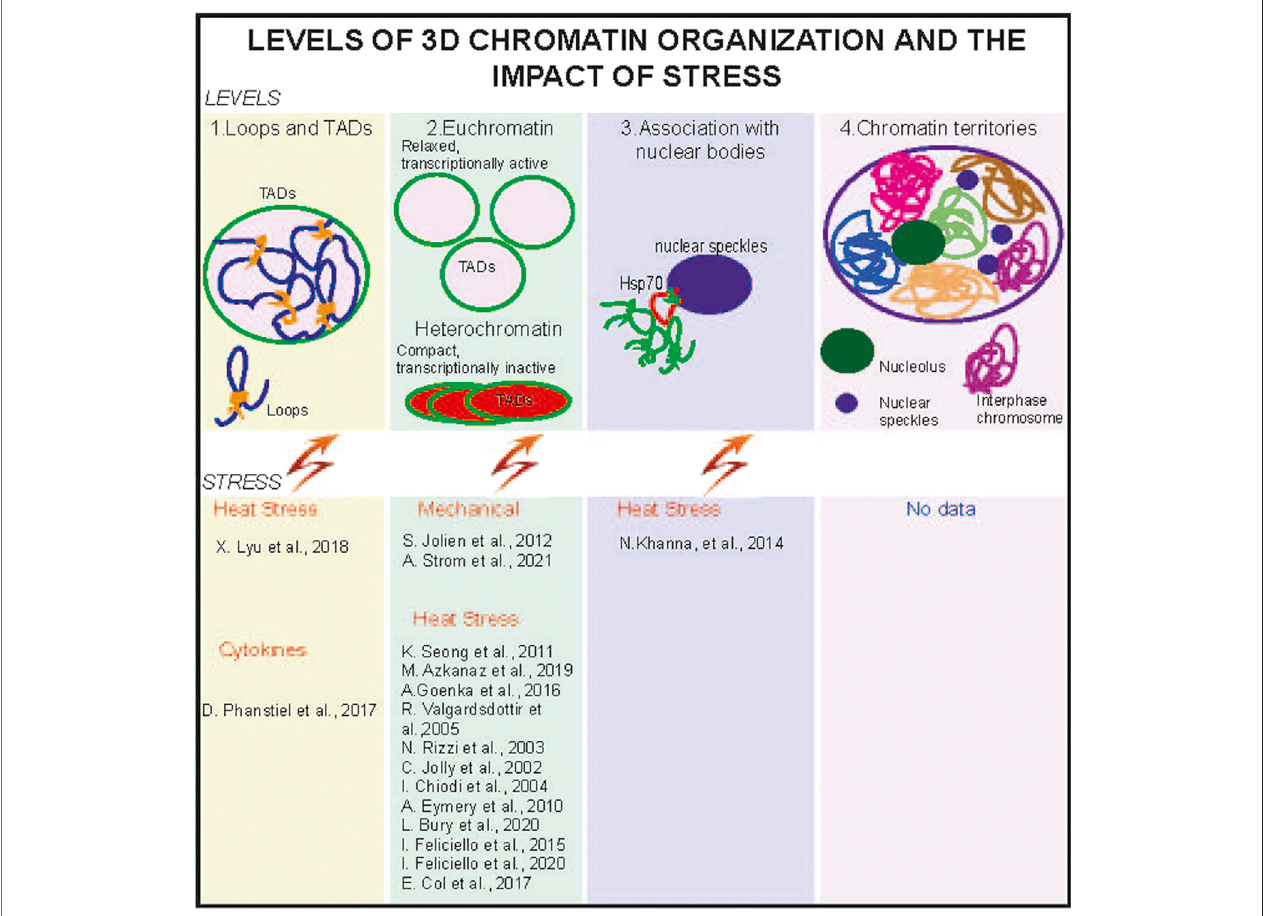
FIGURE 1 | Stress alters 3D chromatin organization at different levels. 3D chromatin is organized at the levels of chromatin loops and topologically associated domains.TADs (1), relaxed and transcriptionally active euchromatin (compartment A), and compact and transcriptionallysilenced heterochromatin(compartment B) (2). Euchromatin regions are often found in the nuclear interior and proximal to nuclear speckles (3). Heterochromatin preferentially localizes at the nuclear and nucleolus periphery. Individual chromosomes form chromosome territories. CT, in interphase nuclei (4), and no data about the stress effects on CTs are available. TADs, heterochromatin, and euchromatin were reported to be affected by several stresses (lower panels) .